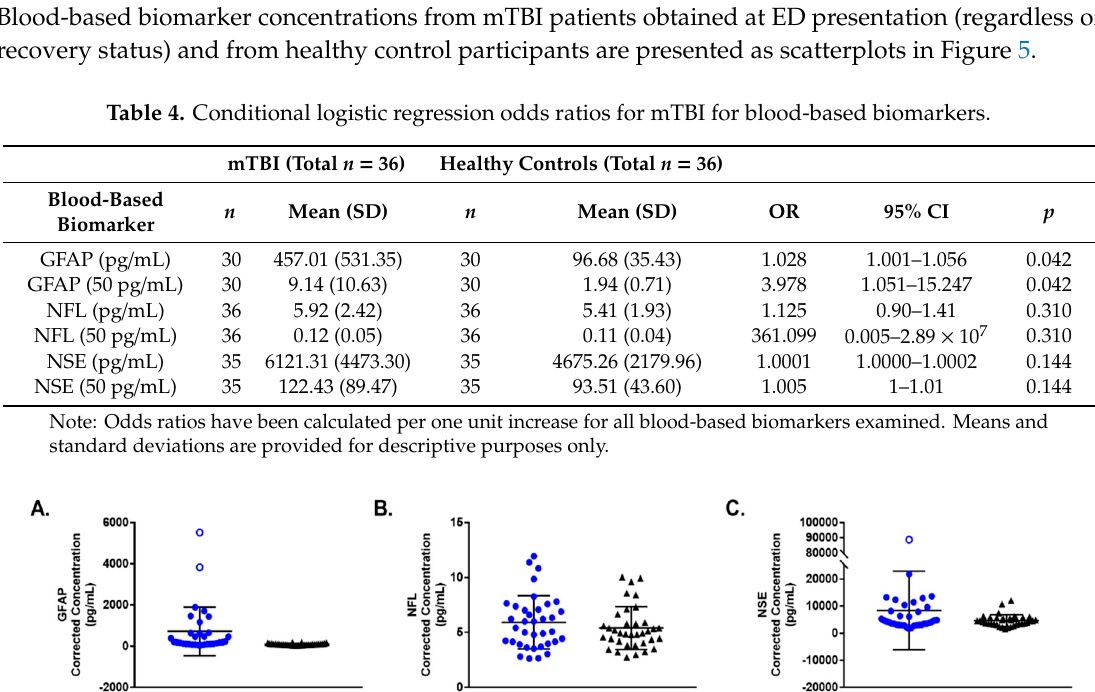
Table 4. Conditional logistic regression odds ratios for mTBI for blood-based biomarkers.